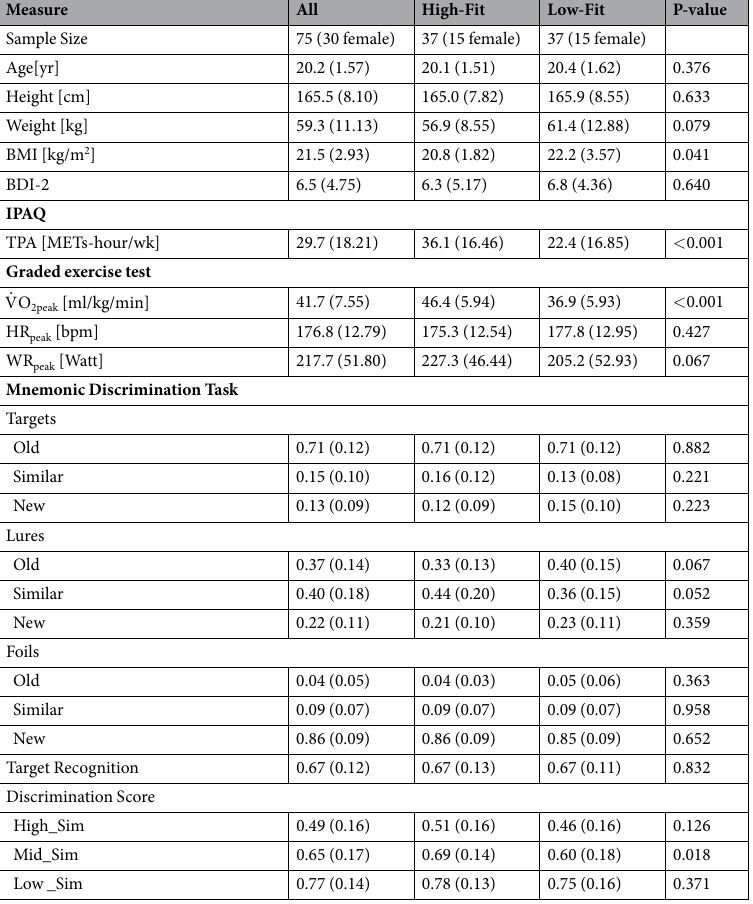
Table 1. Participant demographics, physiological characteristics and behavioral data. Note: BMI = Body Mass Index; BDI = Beck Depression Inventory; IPAQ = International Physical Activities Questionnaire; TPA = Total Physical Activity; METs = Metabolic Equivalent of Task;  V O 2peak = Peak Oxygen uptake; HR = Heart Rate; WR = Work Rate. Values are mean (SD). Behavioral data indicate response proportion of each trial by each response type. P-values indicate the P-values for the independent t-tests comparing High- Fit vs. Low-Fit.  V O 2peak range for male: Low-Fit (n = 22) 30.7–46.1, High-Fit (n = 22) 46.6–57.8; female: Low-